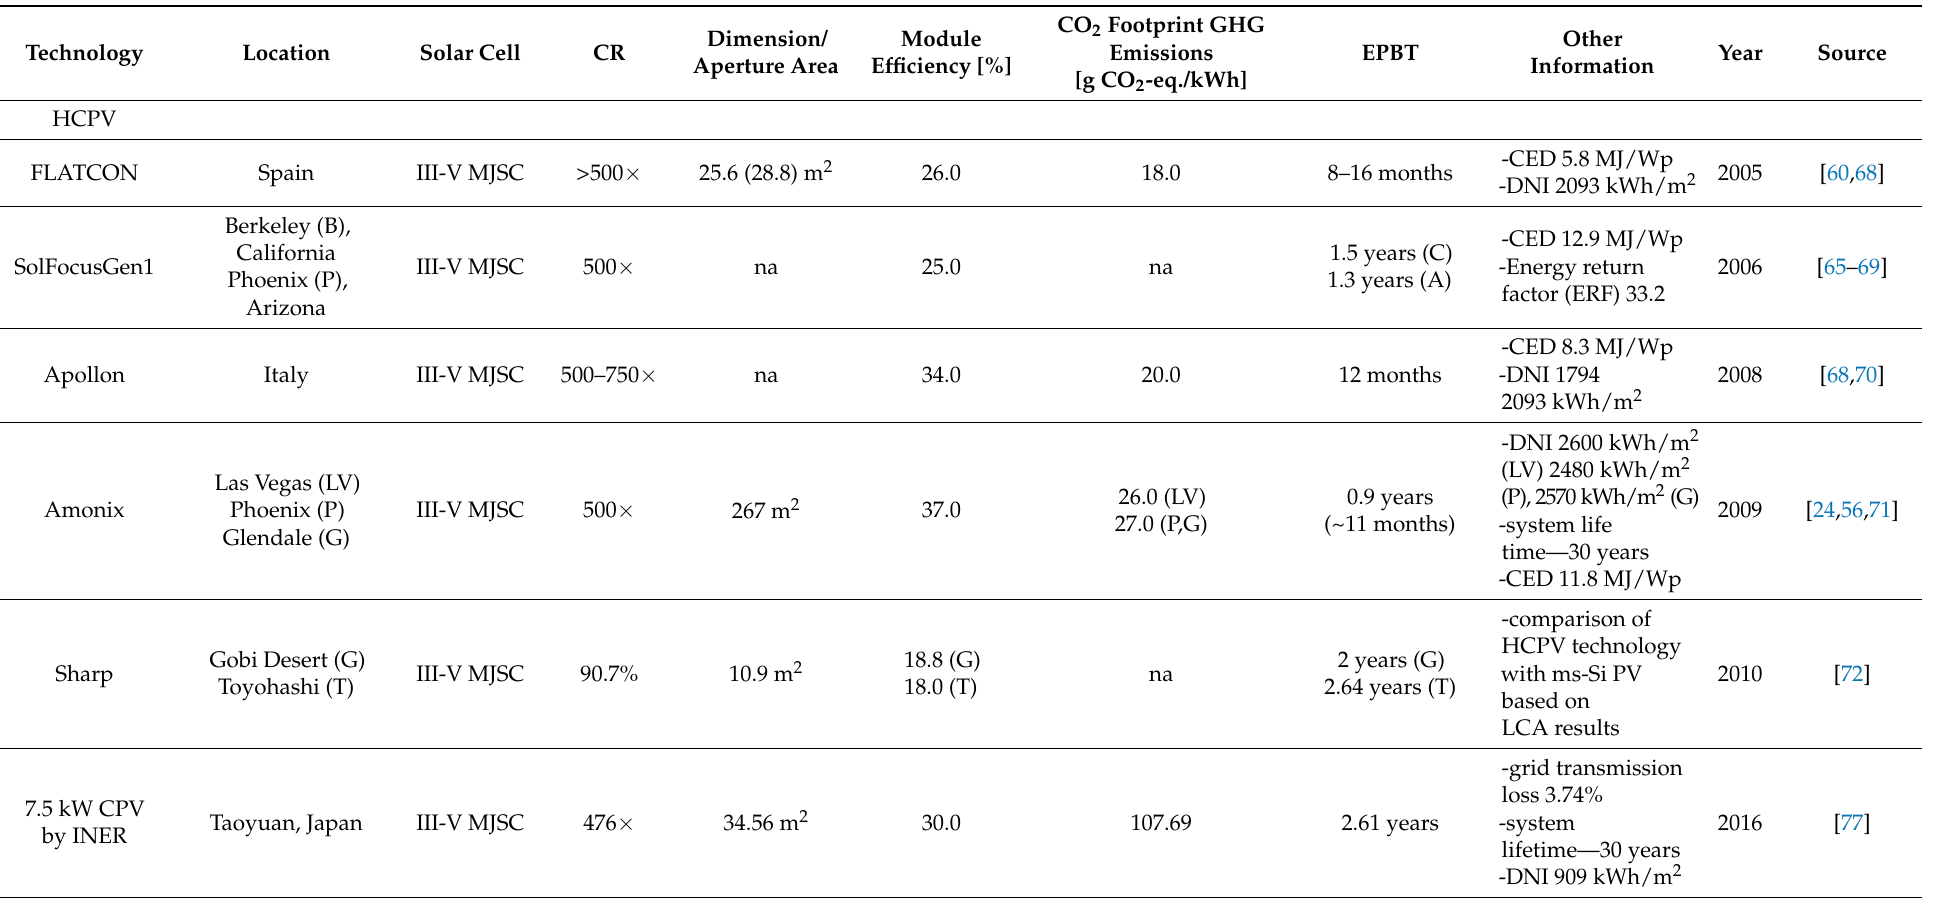
Table 4. Review of life cycle assessment of HCPV and LCPV